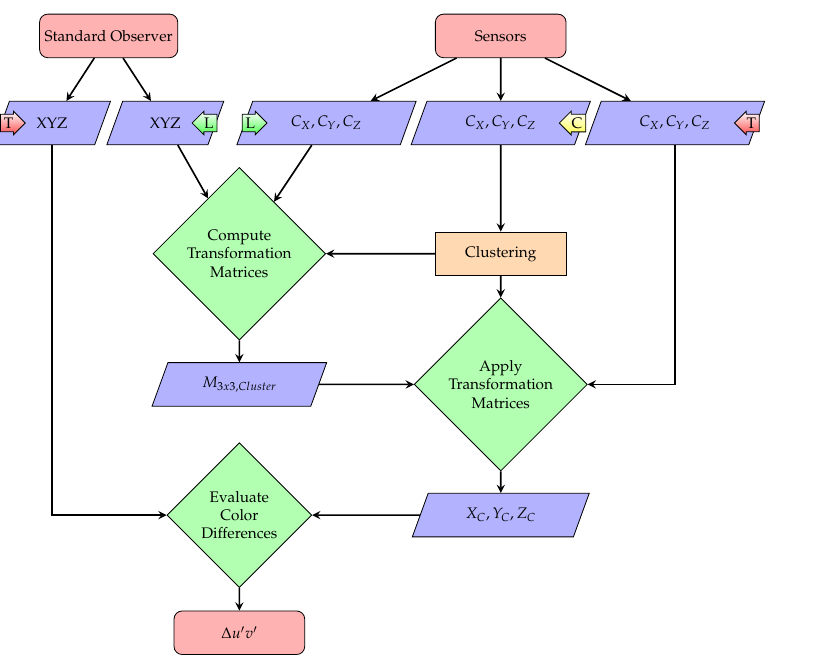
Figure 5. Flow chart of the cluster and evaluation procedure of the new sensor binning approach proposed in this